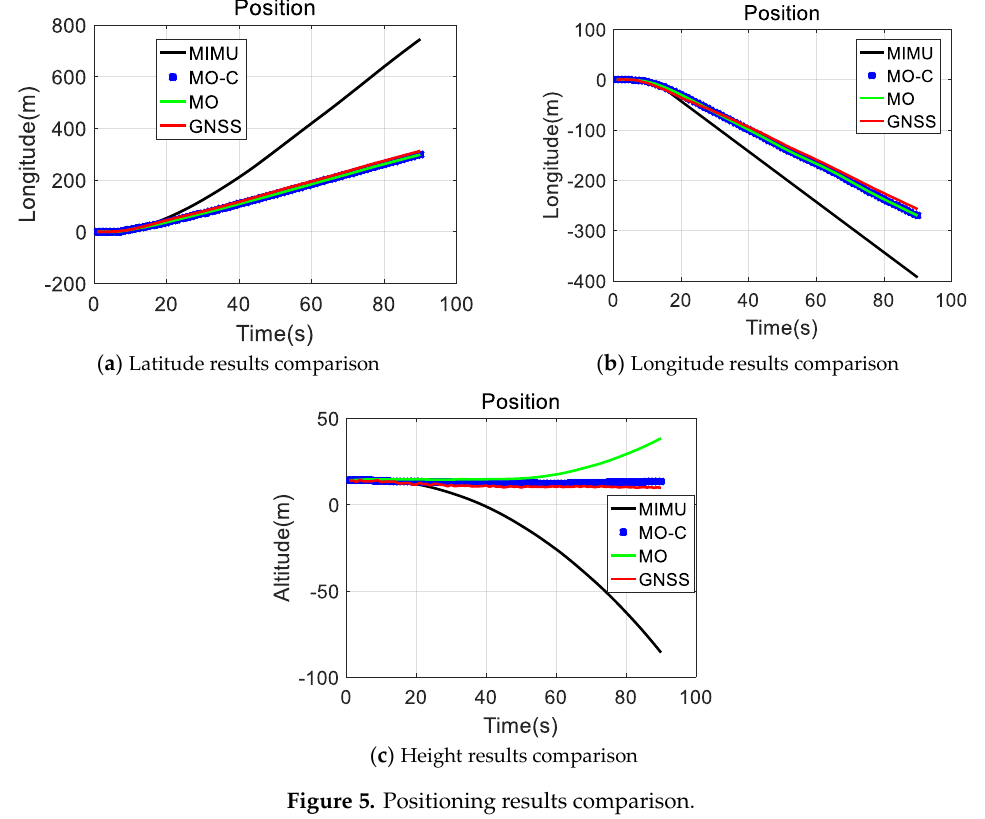
Figure 4. The trajectory from different methods.